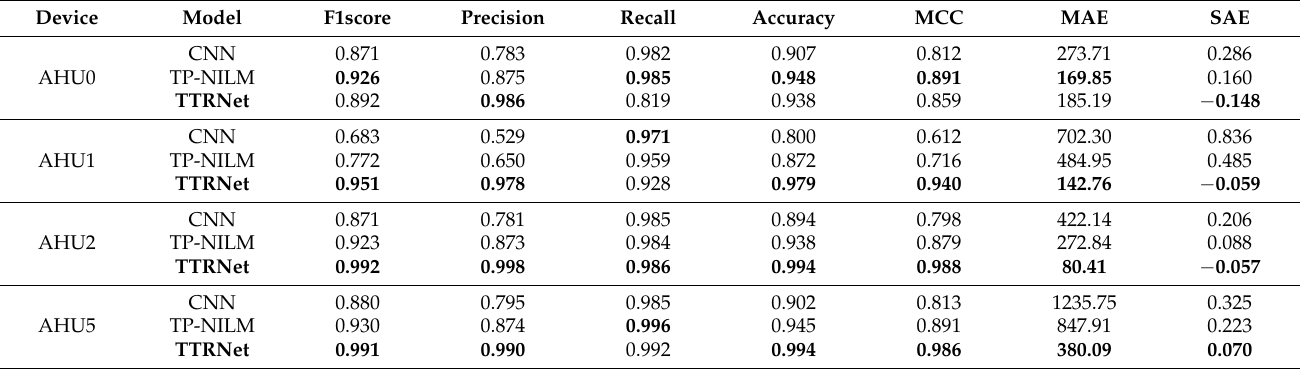
Table 9. Performance comparison of different multi-label classification NILM methods in seen scenarios. The number in bold is the largest of the three model comparisons.